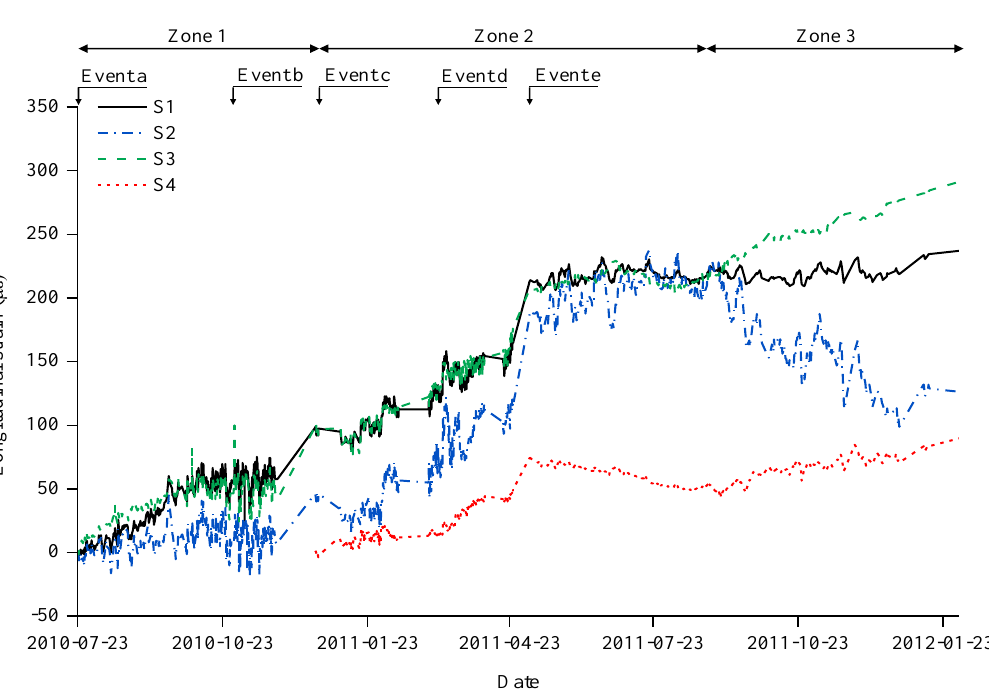
Figure 5. Measurement histories of axial strains in the mega-column during